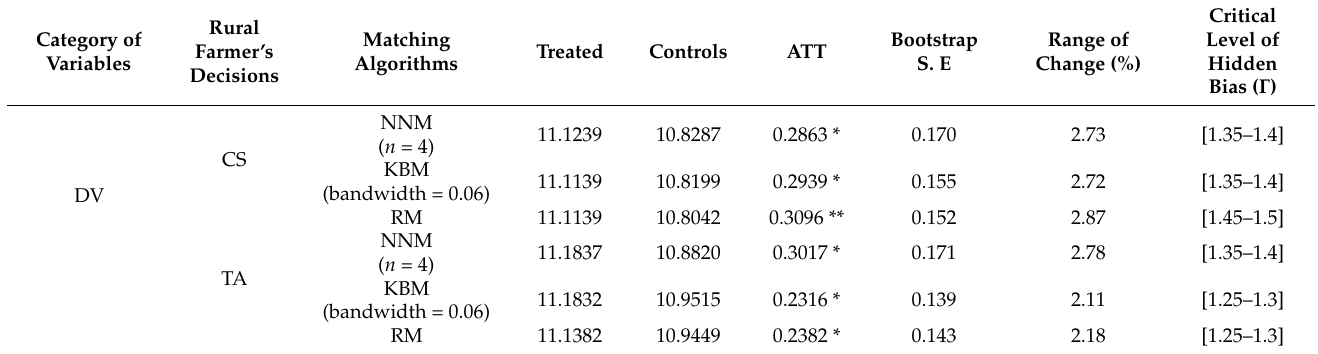
Table 6. The ATT and sensitivity analysis outcome of the whole